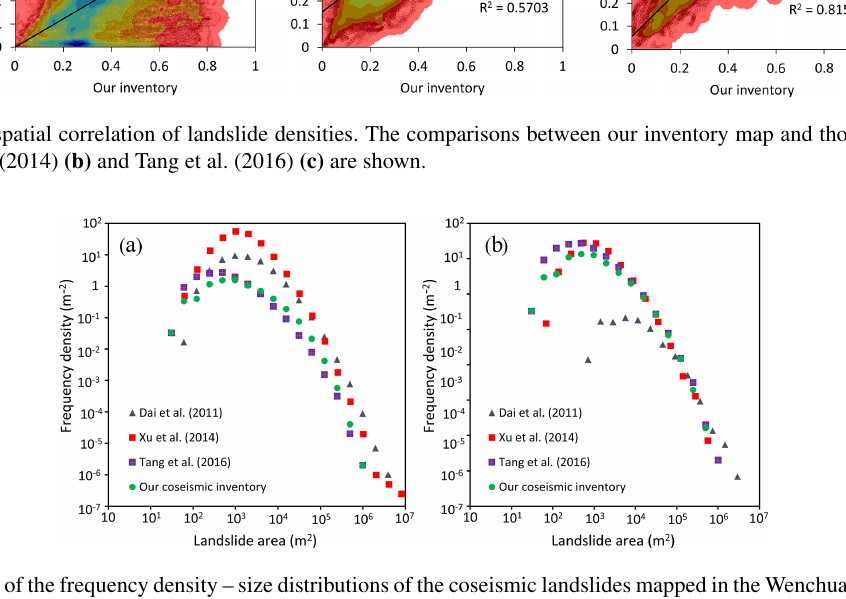
Figure 10. Comparison of the frequency density – size distributions of the coseismic landslides mapped in the Wenchuan earthquake-affected area by Dai et al. (2011), Xu et al. (2014) and Tang et al. (2016). The relationship refers to the whole extension of each inventory in (a) and is limited to the area which is common to all the inventories in (b) , i.e. the area mapped by Tang et al.